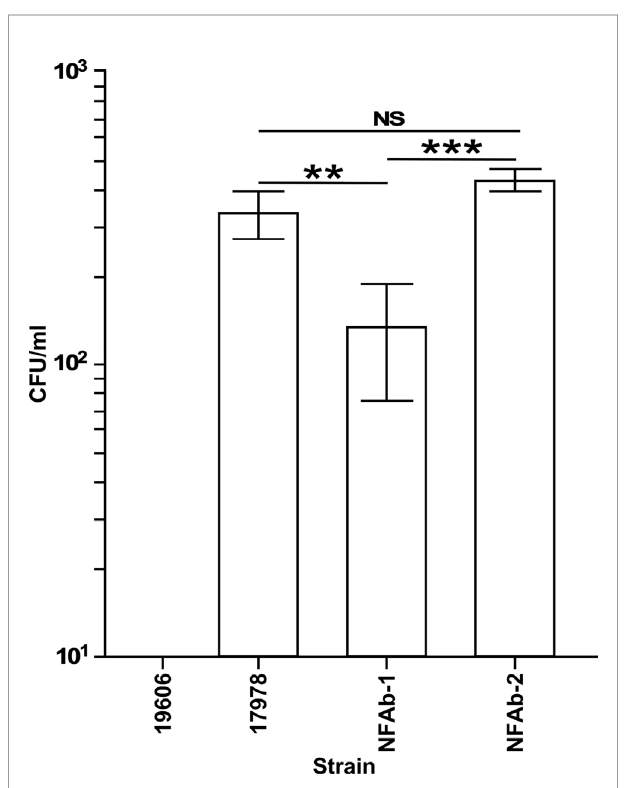
FIGURE 7 | Virulence of different A. baumannii strains. G. mellonella larvae ( n= 30 per experimental condition) were injected with 10 5 bacterial cells of each of the tested strains. Non-injected larvae and larvae injected with sterile PBS were used as negative controls. Larvae were incubated at 37°C and assessed for death at 24-h intervals over 120 hours (5 days). The control data (no injection and PBS injection) are signi fi cantly different from larvae injected with 19606 bacteria ( P = 0.006) or 17978, NFAb-1 or NFAb-2 bacteria ( P ≤ 0.0001). Vertical bars identify statistically different values ( P ≤ 0.05, *; P ≤ 0.0001, ****; NS, not signi fi